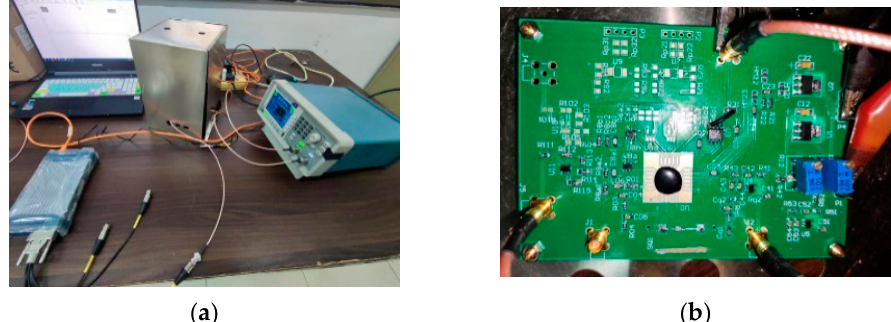
Figure 7. The test system. ( a ) The overall test system. ( b ) The analog amplifier circuit board.